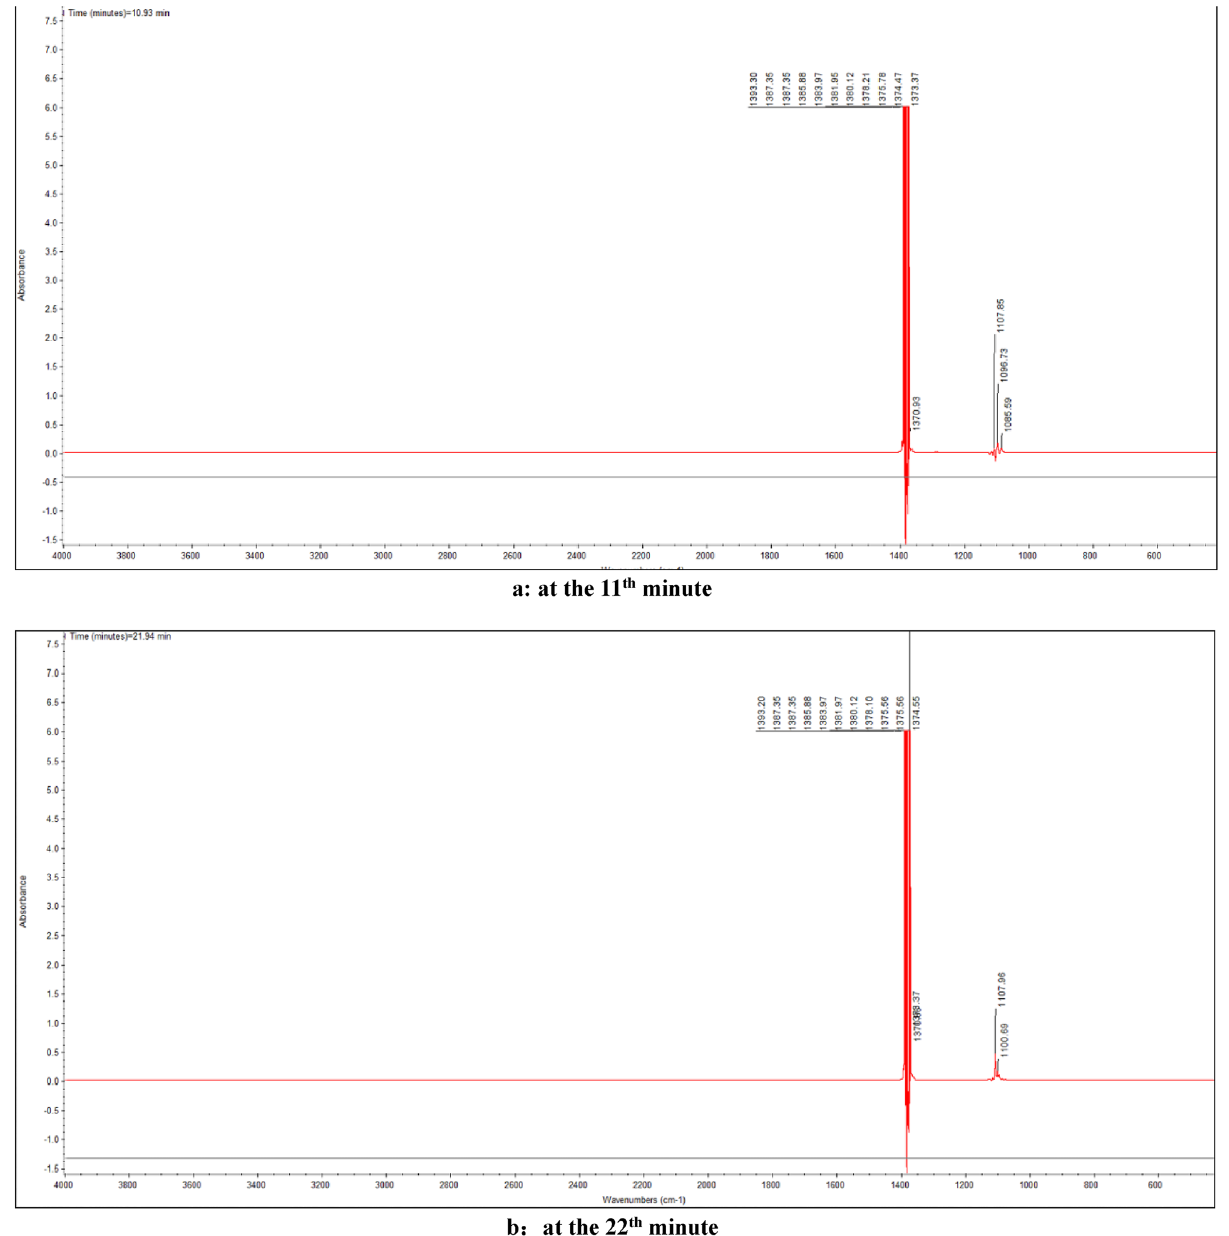
Figure 11. FTIR of gas products from thermal decomposition of 1-nitroso-2-naphthol + NaOH at the 11th minute and the 22th